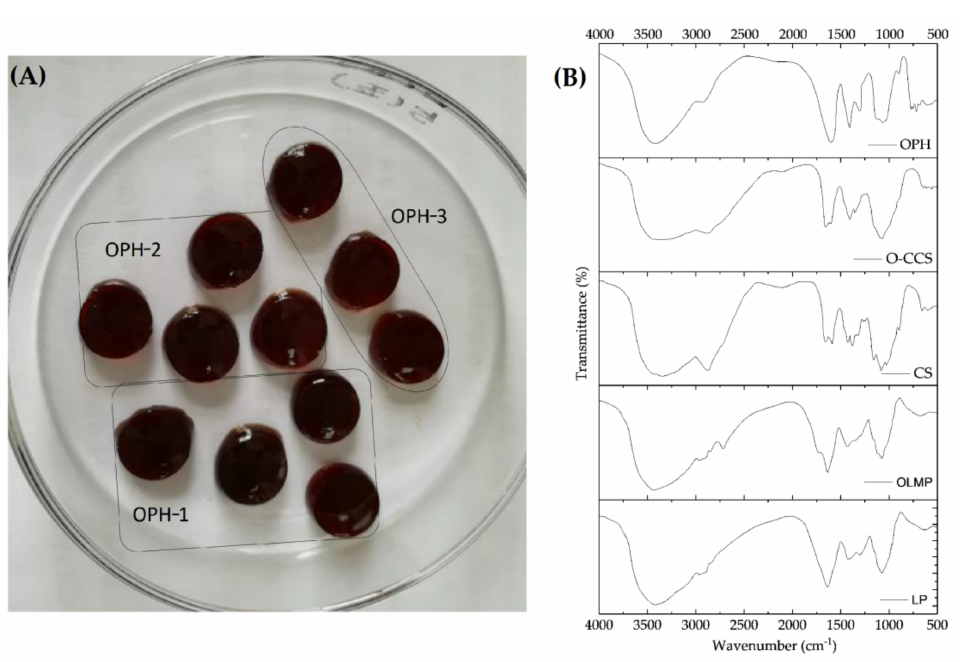
Figure 2. Performance of OPHs ( A ) and FTIR characteristic of OLMP, O − CCS, and OPH − 1 ( B